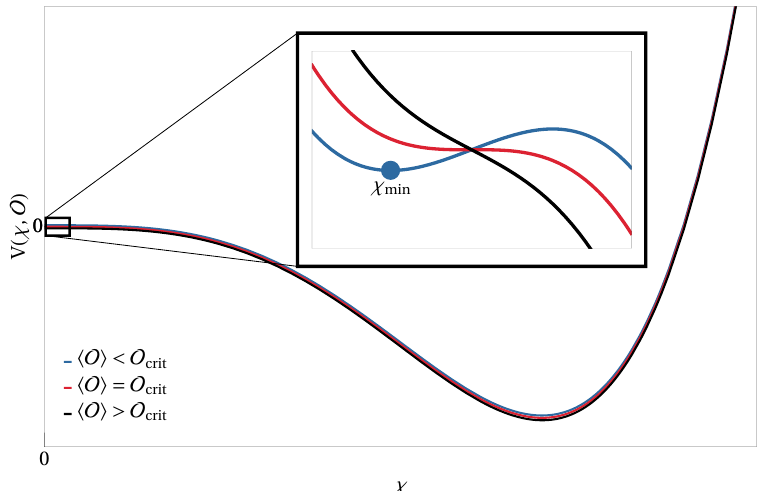
Figure 4 . Sketch of the dilaton potential in eq. (B.1), adapated from ref. [7]. When the VEV of the trigger operator O is less than O curve). The metastable minimum disappears as hOi is raised beyond O leaving only the true vacuum, which has a large negative energy